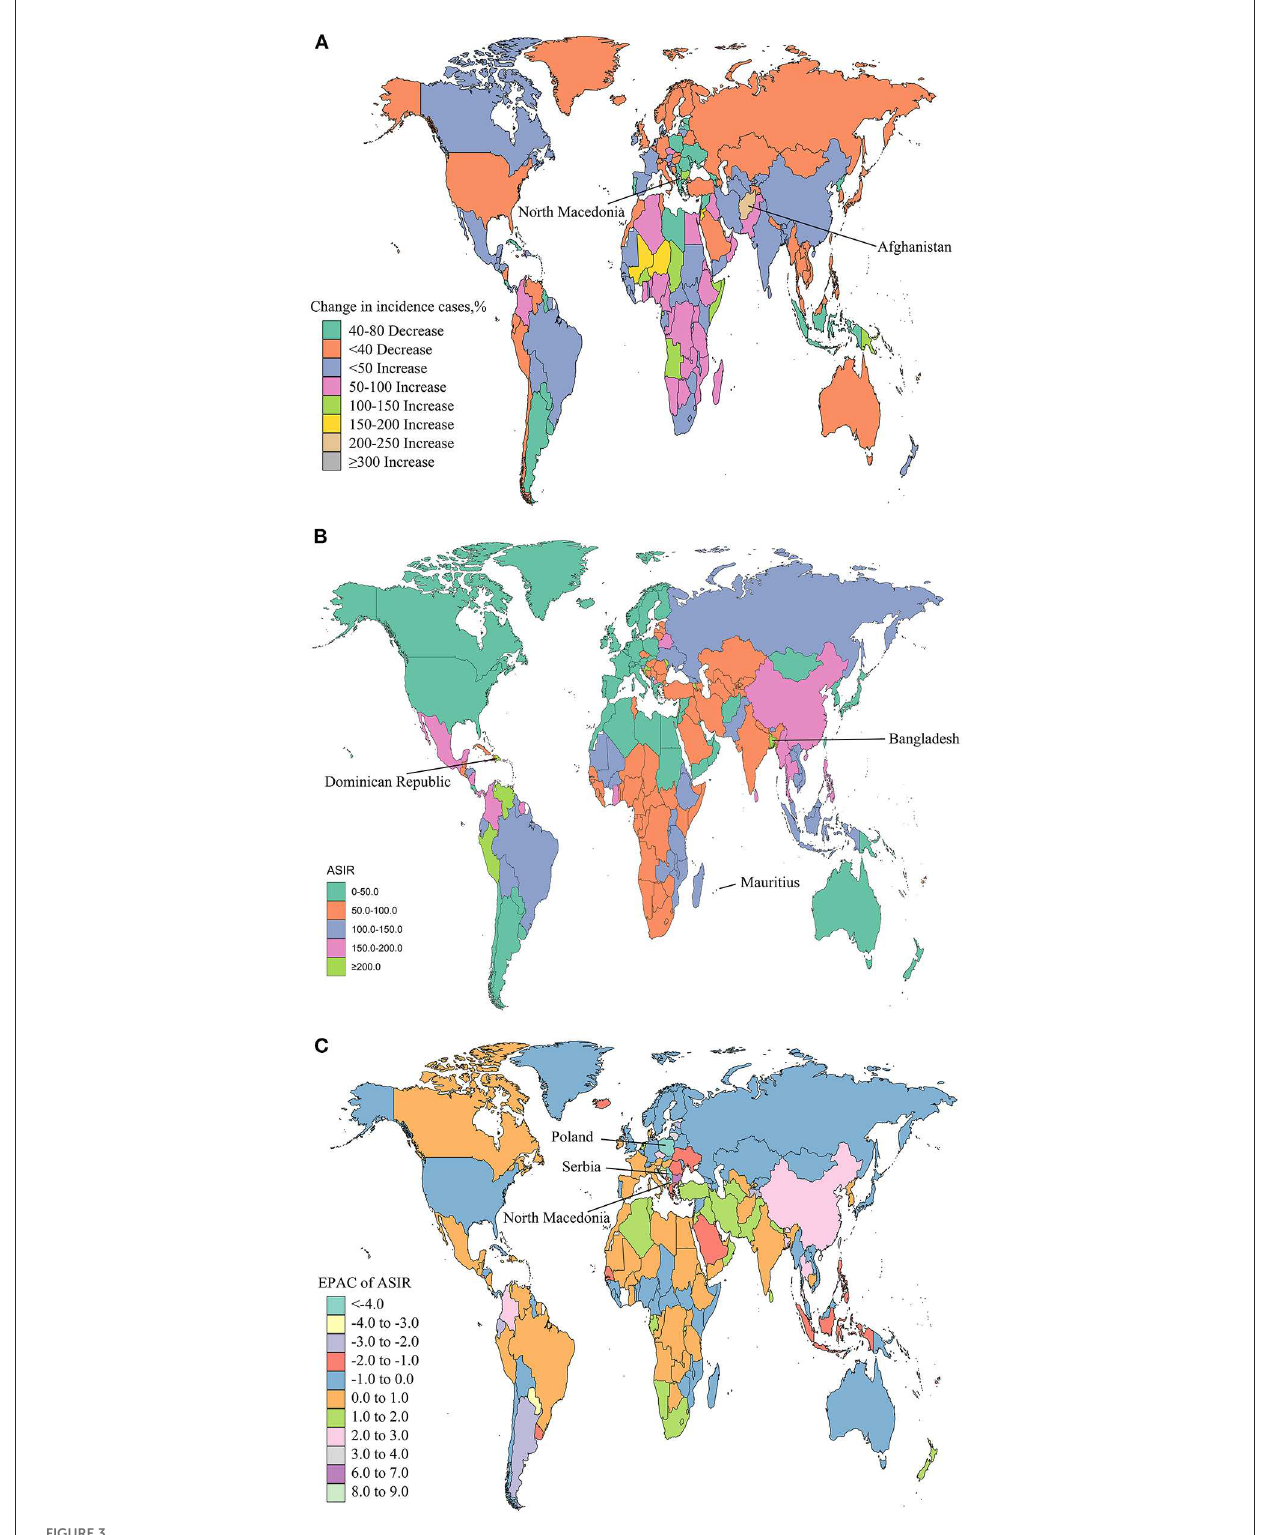
FIGURE3 Global trends in the incidence of NSNIs in 204 countries and territories. The percentage of relative change in incident cases of NSNIs between 1990 and 2019 (A) , age-standardized incidence rates (ASIRs) of NSNIs in 2019 (B) , and estimated annual percentage changes (EAPCs) of ASIRs of NSNIs from 1990 to 2019 (C) were